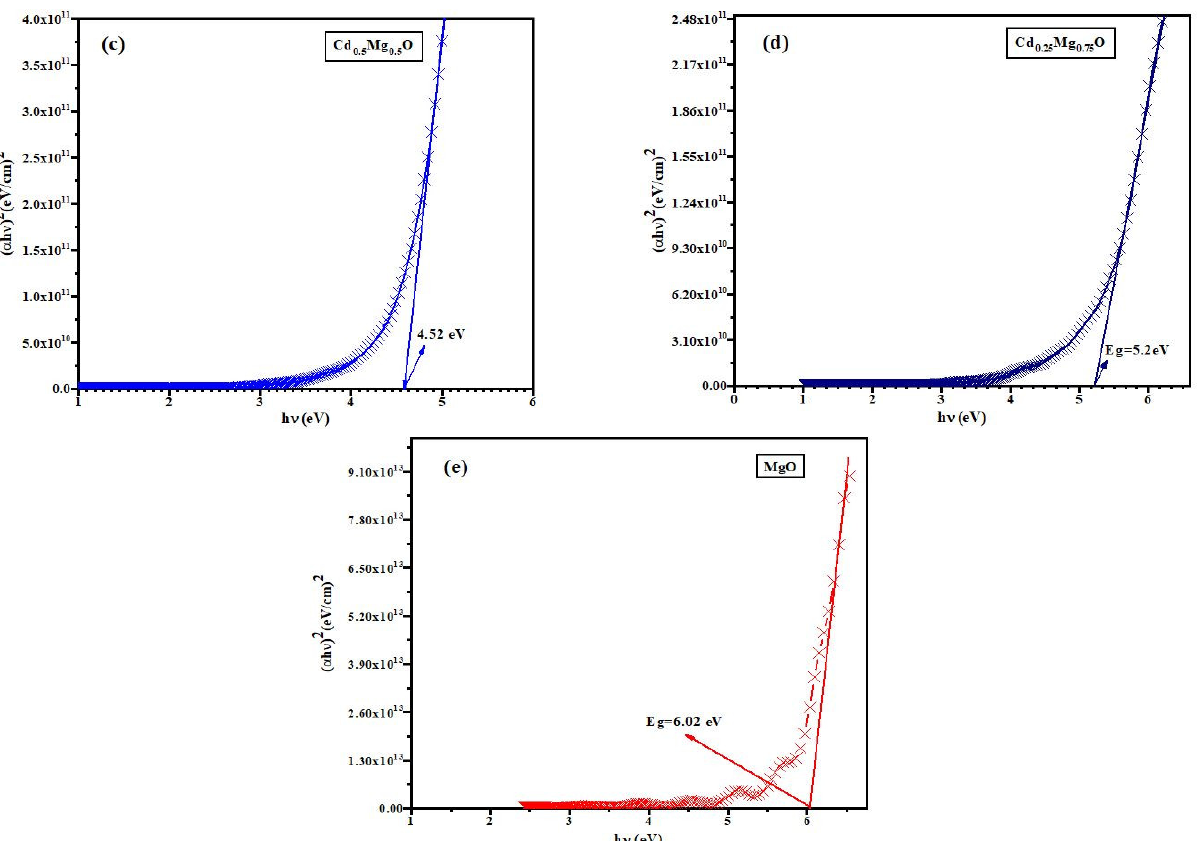
Figure 7. Energy band gap of ( a ) CdO ( b ) Cd 0.75 Mg 0.25 O ( c ) Cd 0.5 Mg 0.5 O ( d ) Cd 0.25 Mg 0.75 O ( e ) MgO annealed thin films.